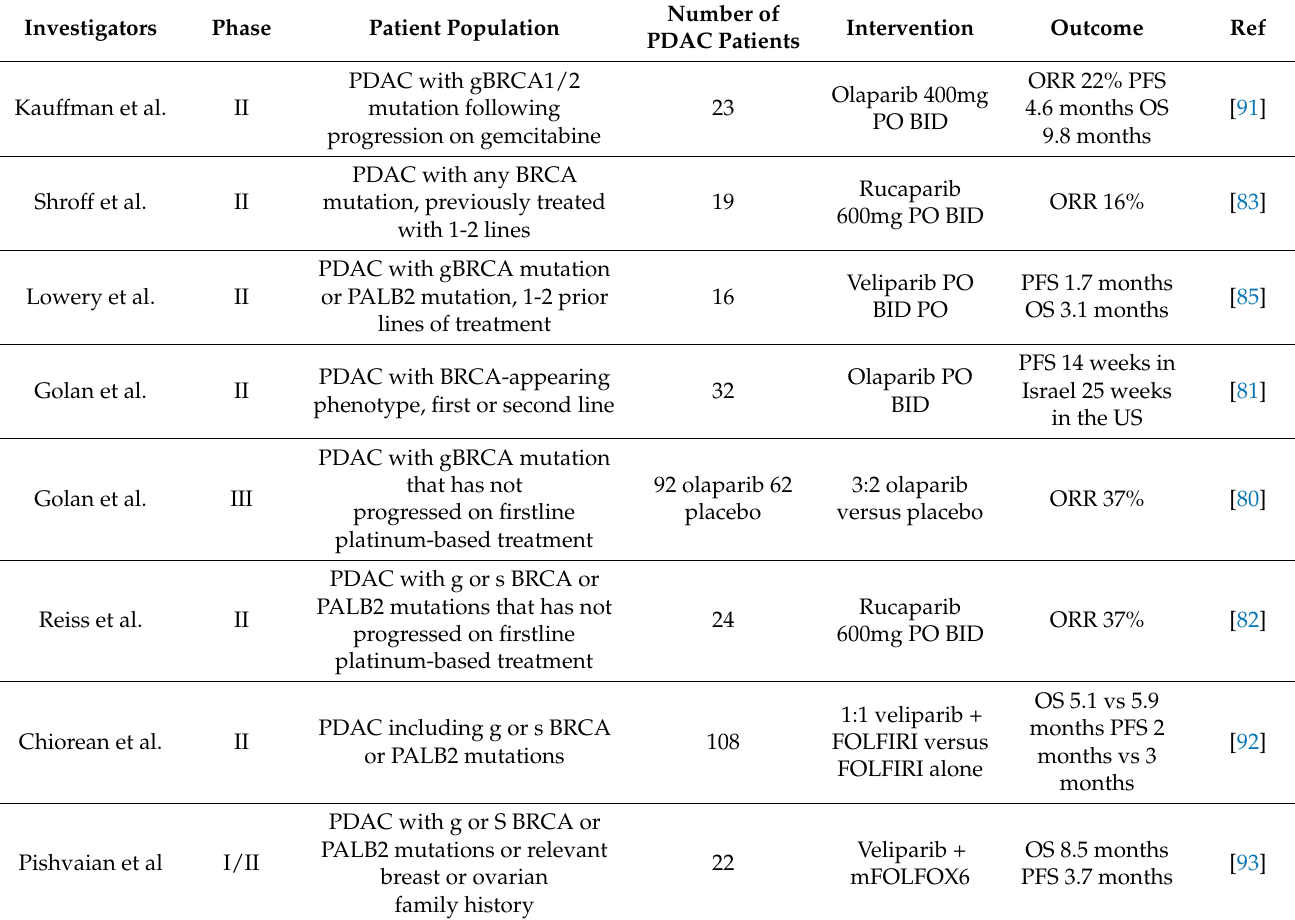
Table 1. Recent advances in PARP inhibitor therapy, adapted from Gupta and colleagues